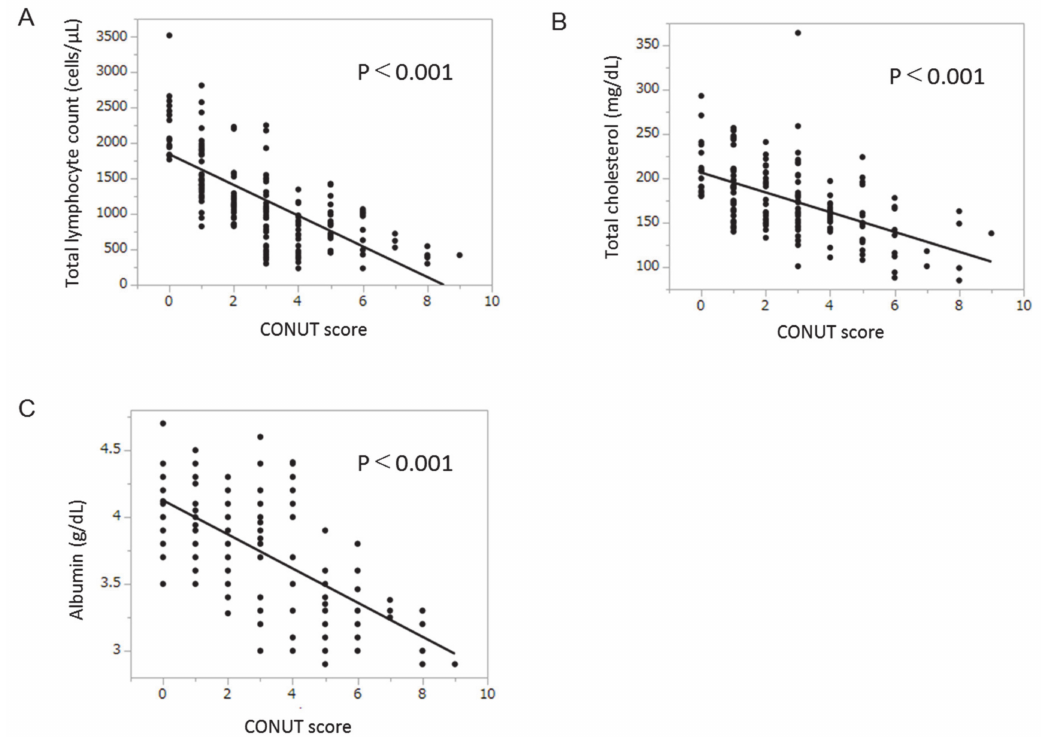
Figure 4. Correlations between CONUT score and total lymphocyte count, total cholesterol level, and albumin level. ( a ) Correlation between CONUT score and total lymphocyte count; ( b ) correlation between CONUT score and total cholesterol level; ( c ) correlation between CONUT score and albumin level. Abbreviations: CONUT, Controlling Nutritional